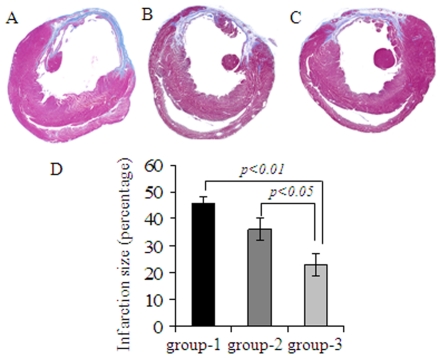
Shh overexpression attenuated infarction size expansion.Masson's trichome staining of formalin fixed paraffin embedded of the histological sections from (A) group-1 (B) group-2 and (C) group-3 animal hearts was carried out to visualize the area of fibrosis. Infarction size was significantly attenuated in group-3 after ShhMSCs engraftment as compared with groups-1 and 2.